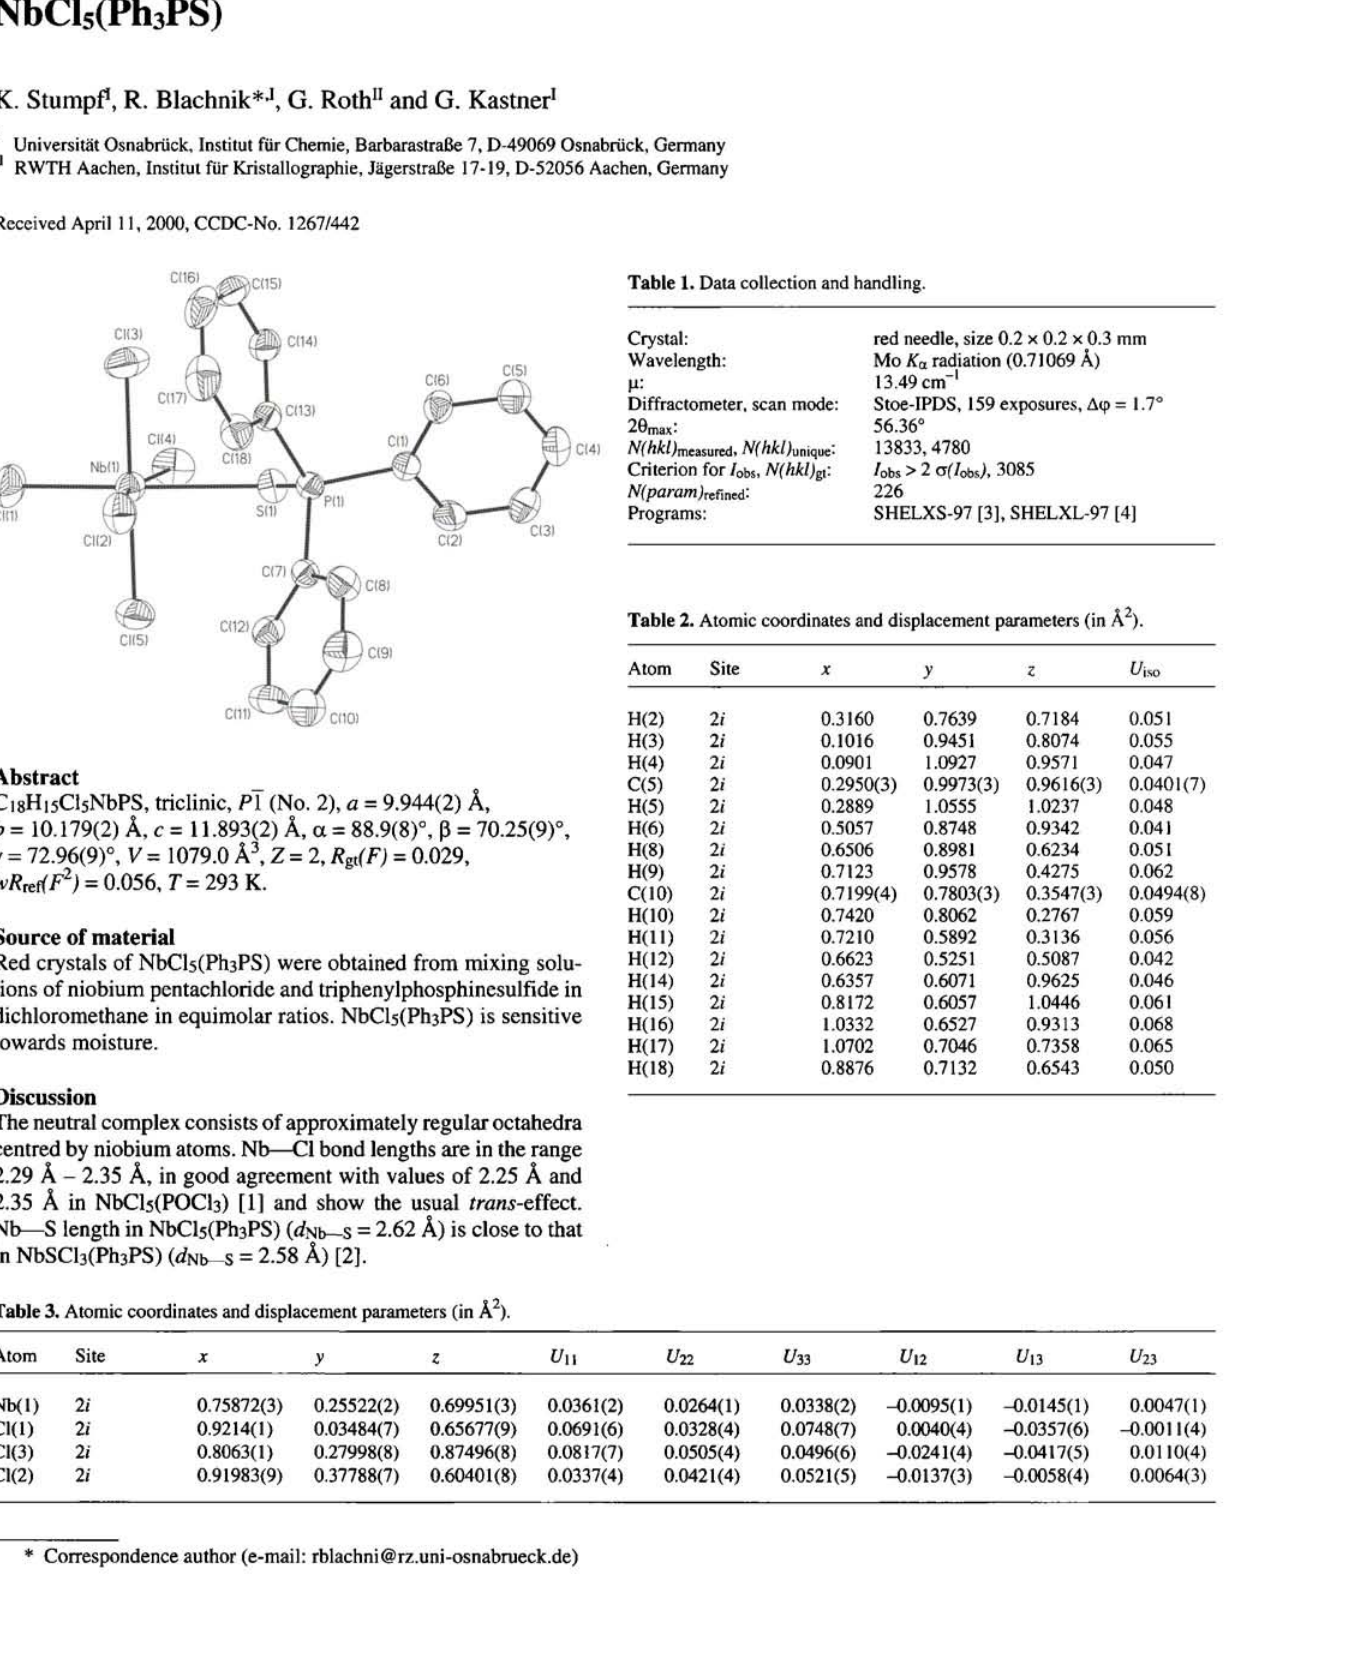
Table 1. Data collection and handling.